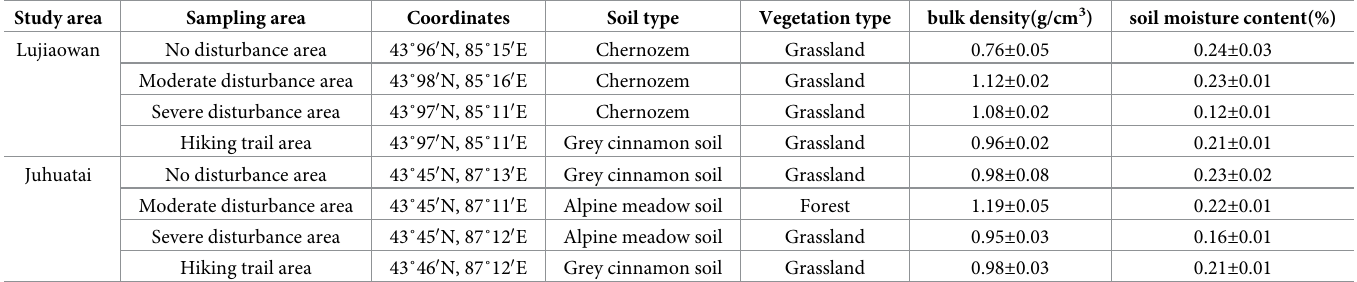
Table 1. Overview of sampling